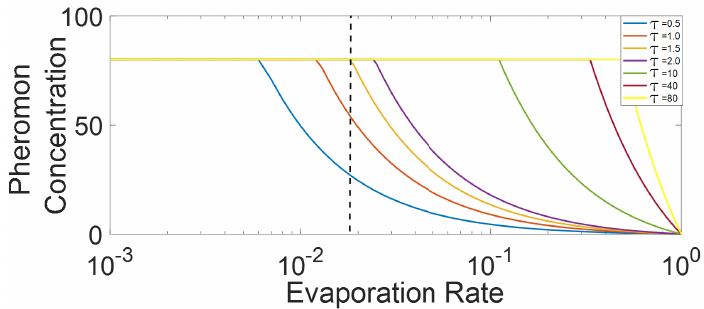
Figure 9. Approximate σ sat calculated for different τ is presented against evaporation rate ( r e ). The dotted line represents the r e that has been used for the analysis in the Section 5 ( r e = 0.02, σ sat = 80 p units / cell